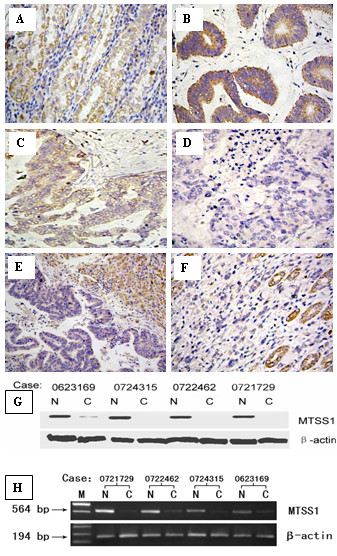
Analysis of MTSS1 expression in human gastric cancers and adjacent normal mucosa specimens. A: Normal (nonneoplastic) gastric mucosa; B and C: Gastric cancer positive expression of MTSS1 in well-(B) and moderate-(C) differentiated tumors. D: Gastric cancer negative MTSS1 expression; E: MTSS1 expression in the hepatic metastasis and adjacent nonneoplastic liver tissues; F: MTSS1 expression in gastric cancer and adjacent nonneoplastic mucosa tissues; G and H: Western blotting analysis (G) and RT-PCR analysis (H) of MTSS1 in GC tissues and surrounding nontumor tissues, β-actin as a parallel control, N: surrounding nontumor tissues; T: tumor tissues.